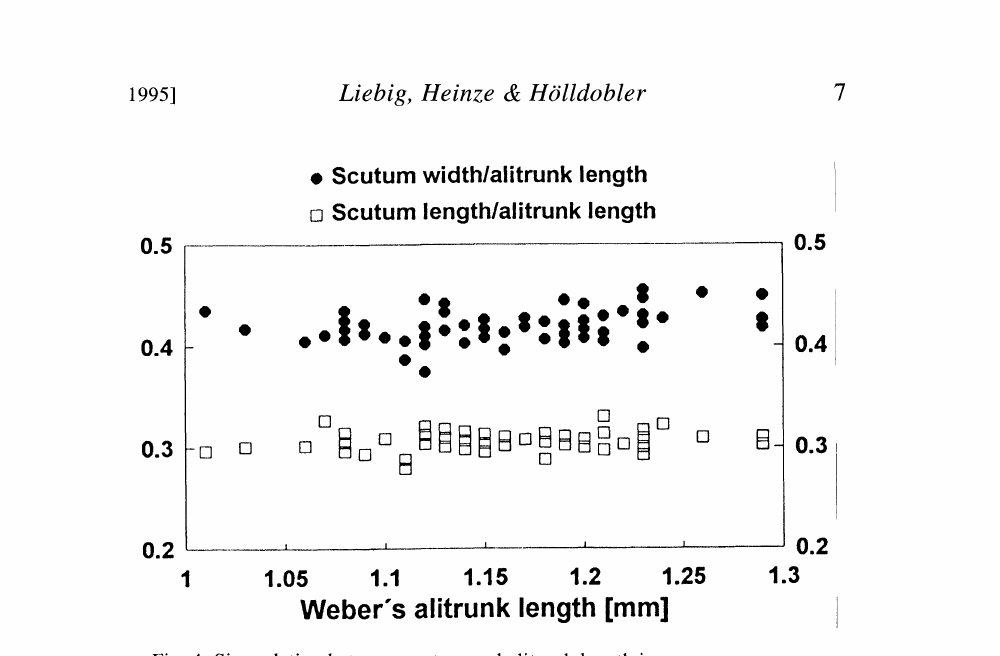
Fig. 4" Size relation between scutum and alitrunk length in queens.